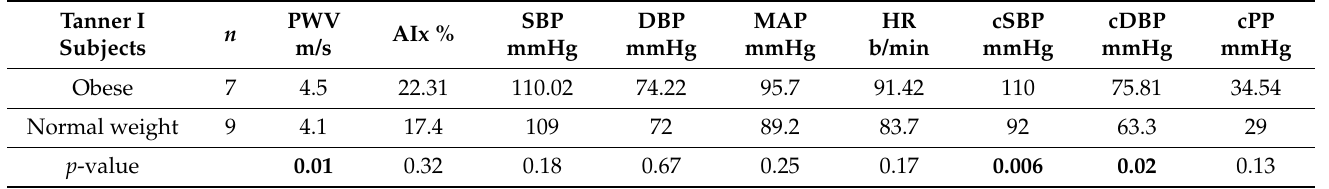
Table 10. PWA parameters comparison in Tanner Stage I subjects.